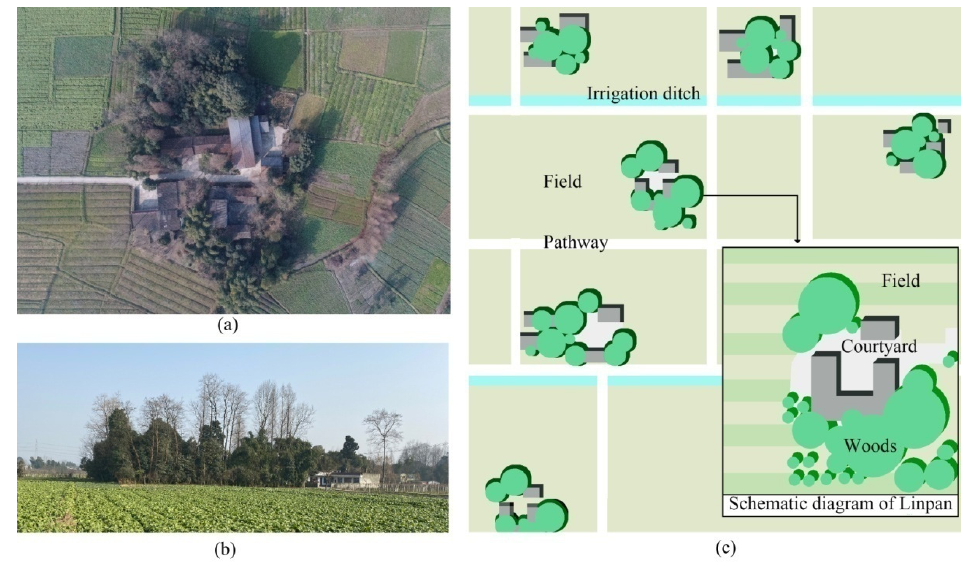
Figure 2. Real scene and structure diagram of Linpan in Chengdu Plain: ( a ) top view of a piece of Linpan, ( b ) side views of a piece of Linpan, and ( c ) distribution pattern and internal structure of Linpan.